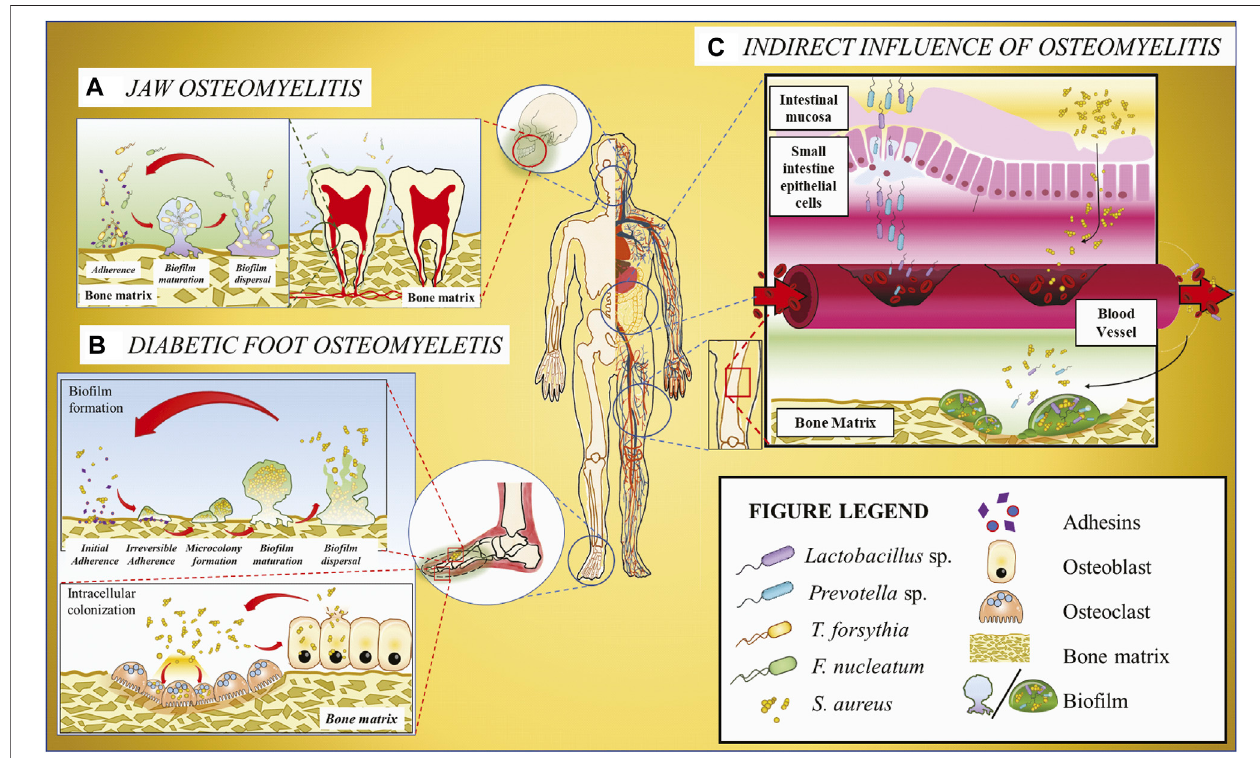
FIGURE 1 | Schematic illustration of the host microbiome ’ s impacts on osteomyelitis. (A) Jaw osteomyelitis associated with two bacteria T. forsythia and F. nucleatum acts as a bridging bacterium to facilitate T. forsythia colonization and subsequent bio fi lm formation. (B) DFO involving S. aureus . As the most prevalent osteomyelitic pathogen, S. aureus may generate bio fi lm on the bone matrix or invade osteoclasts and osteoblasts mediated with adhesins, and the released bacteria from cells can be recovered to the original state. (C) Osteomyelitis or other osseous diseases associated with infectious microorganisms originating from gut microbiota. Some bacteria, e.g., Lactobacillus and Prevotella , translocate from gastrointestinal tract to the blood vessel across the gut epithelium barrier and then colonize in the bone matrix through the systematic circulation, ultimately resulting in osseous diseases.